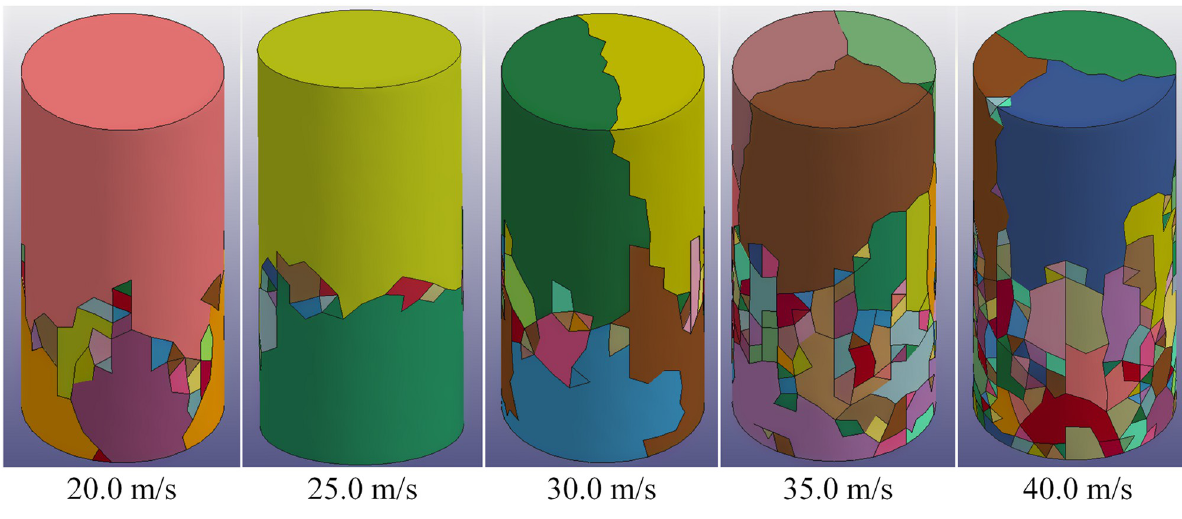
Fig 9. Numerical simulation results of granite samples under different impact velocities (the lower face is the impacting face).